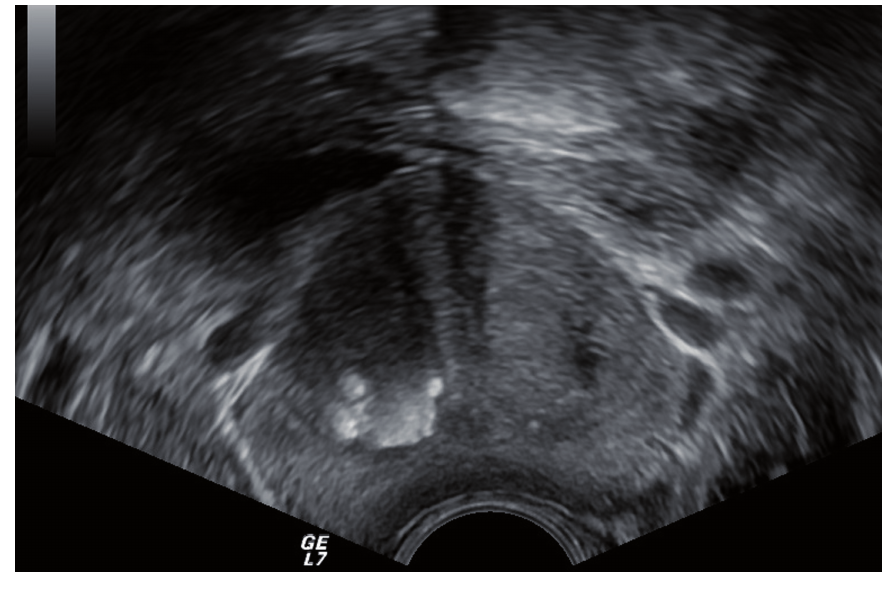
figure 1 - Transrectal ultrasound in axial section of prostate shows marked calcifications with multiple hyperechoic foci and with significant area ( ≥ 3mm) with coarse shadow.